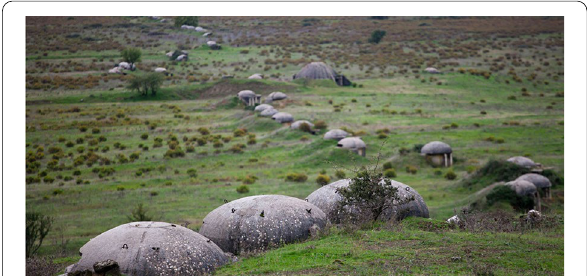
Fig. 1 Picture from the bunkers in Albanian